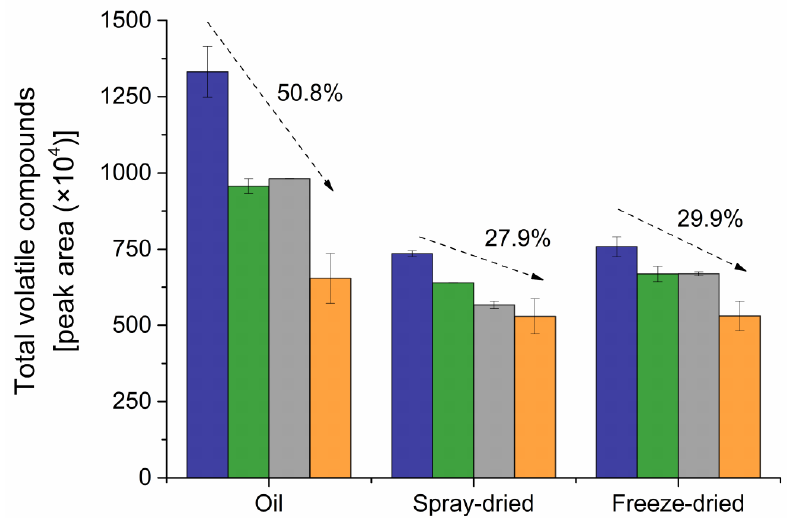
Figure 3. The effects of drying methods for the encapsulation of RCO on the peak areas of the total volatile compounds detected in the samples under storage. Analyses were carried out at day 0 ( ), day 10 ( ), day 20 ( ), and day 30 ( ).